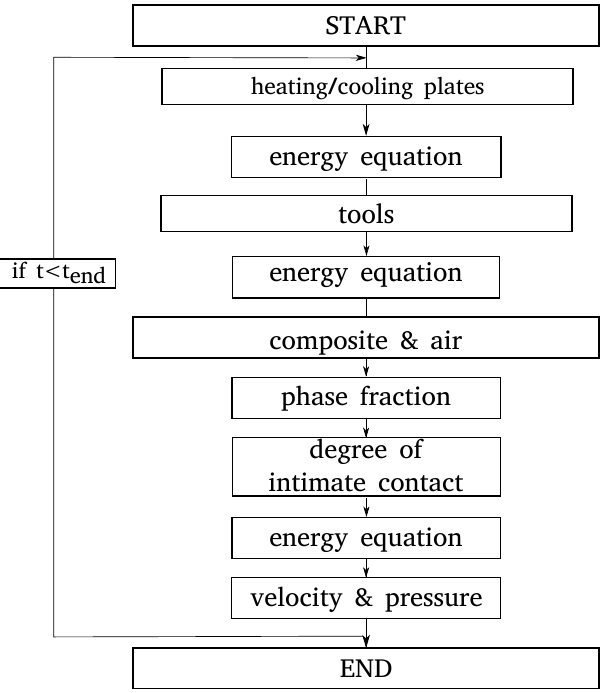
Figure 2. Flowchart for modeling of the consolidation